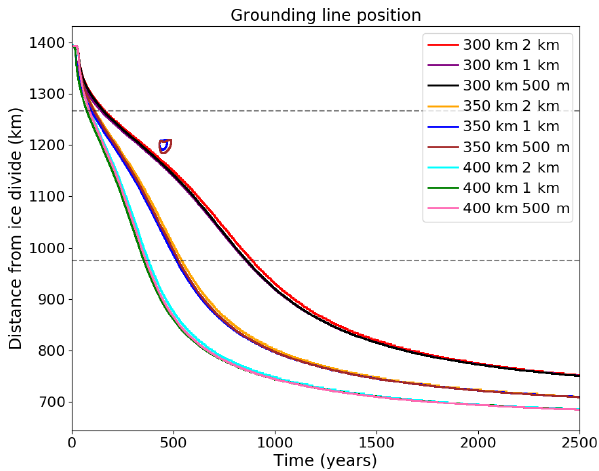
Figure A1. Grounding line retreat for the mesh resolution depen- dence experiments using the cavitation sliding relation. Buttressing parameters of 300, 350 and 400km are used with 2km, 1km and 500m uniform element size in the horizontal.